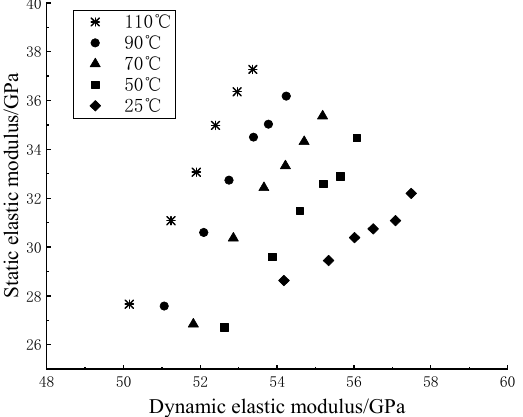
Figure 4. The cross-plot of the dynamic elastic modulus and static elastic modulus of specimen Figure 4. The cross ‐ plot of the dynamic elastic modulus and static elastic modulus of specimen #5.